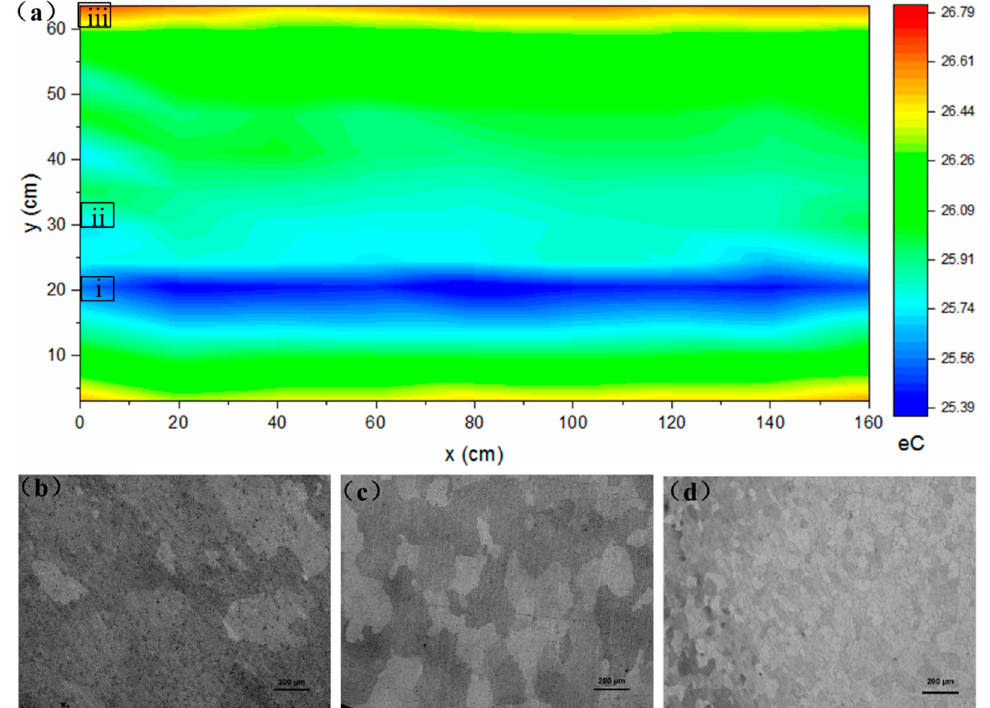
Figure 2. Eddy currents and classical optical microstructures of 6005A-T6 alloy. ( a ) The linear contour plot of the eddy current of the naturally aged 6005A-T6 alloy. ( b – d ) The screened-out microstructures with an eddy current of 25.58 MS/m, 26.24 MS/m, and 28.10 MS/m, which endured a constant immersion for 240 h in 3.5 wt % NaCl and are labeled as i–iii in ( a ), respectively. The maximum and minimum values of the eddy current are set to 26.79 MS/m and 25.39 MS/m in the red-green-blue (RGB) color scale in order to present the various zones clearly. The rectangles in ( a ) schematically highlight the positions of these three samples in ( b – d ), respectively.